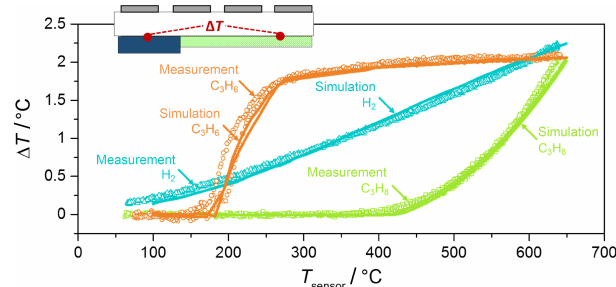
Figure 9. Measured (points) and simulated (lines) temperature dif- ference (cid:49)T between the catalytically activated and inert parts of the sensor when the overall sensor temperature was modulated, as shown in Fig. 8. The curves for different analytes (1000ppmC 3 H 6 , 5000ppmC 3 H 8 , or 5000ppmH 2 in 10% O 2 and N 2 ) differ markedly; however, these differences are mirrored by the simula- tions. The inset scheme illustrates at which points the temperature difference was